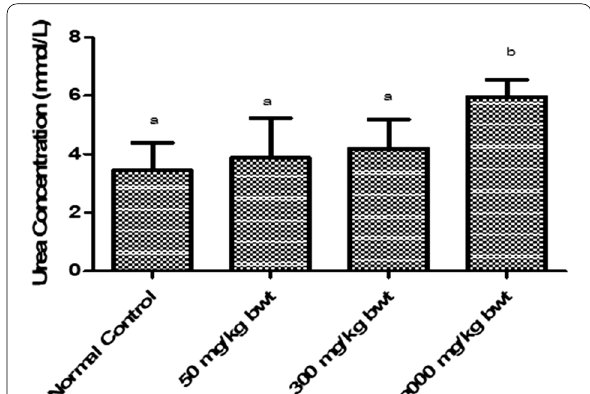
Fig. 3 Serum Urea Concentration in Control and Treatment Groups.